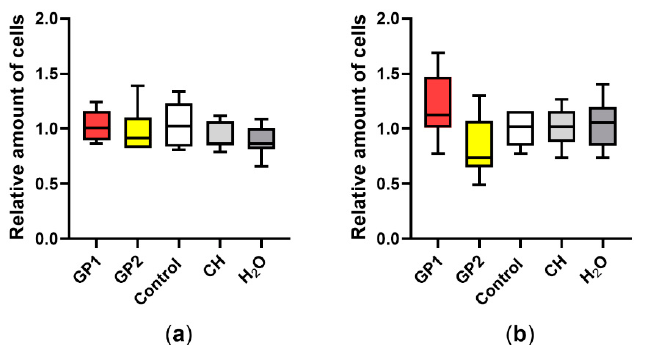
Figure 2. Total cell number according to the trypan blue exclusion assay: ( a ) comparison of unexposed THP-1 (Control), THP-1 exposed to GP, sodium cholate (CH) and H 2 O after 40 h of exposure; ( b ) after cotreatment with cytochalasin B (5 µg/mL). Data are normalized to the control (untreated THP-1) and are presented in a boxplot with a median with an interquartile range; n = 9.